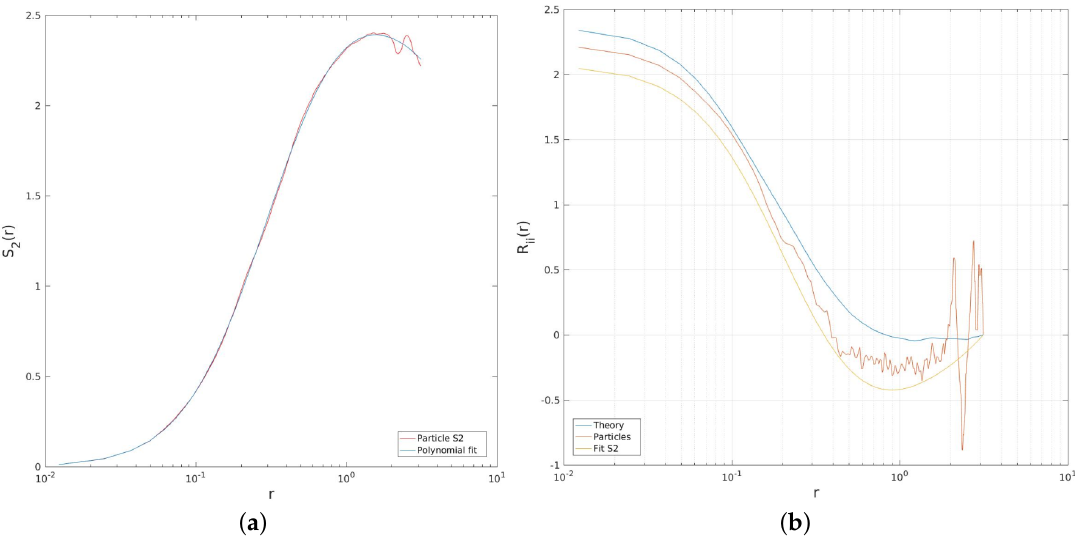
Figure 10. Second-order structure function for the particles with a sixth-order polynomial fit (( a ) panel). The two-point velocity correlations calculated using (8) and (13), for the raw particle data ( red ), from the polynomial fit of S 2 l ( yellow ) and derived from the theoretical structure function (( b )